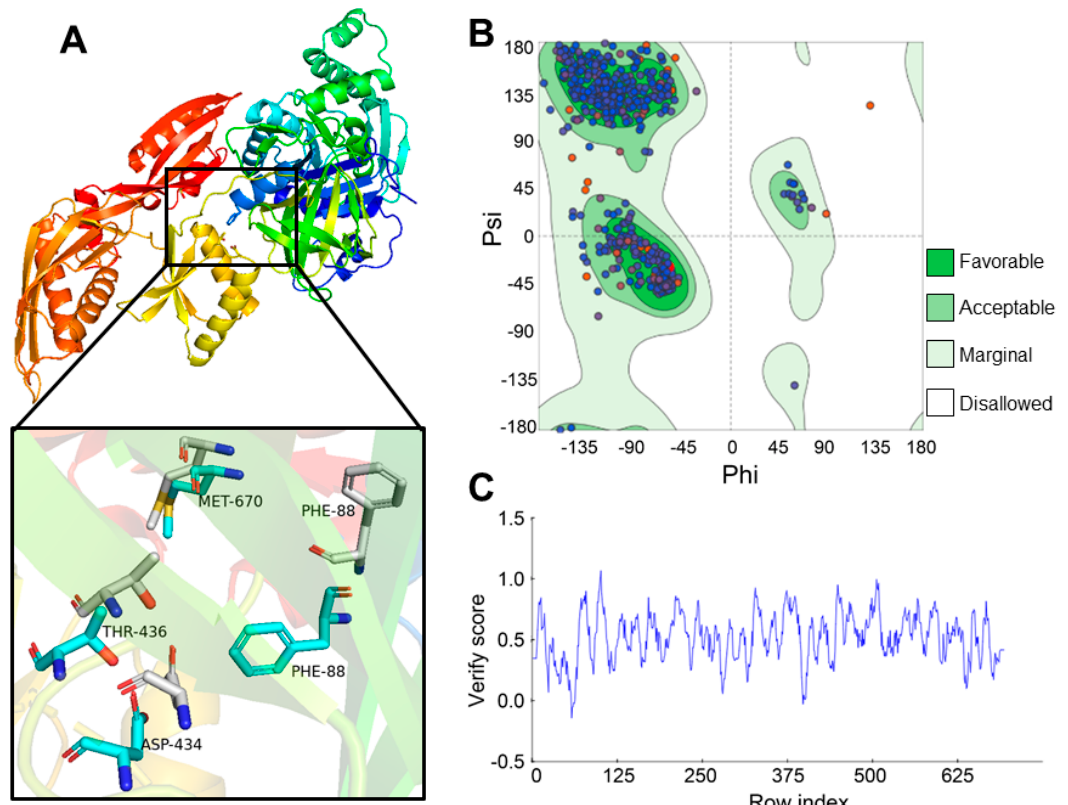
Figure 3. ( A ) 3D homology model of EF-G structure for docking; key residues related to the FA binding in the homology model are shown in the expended figure (cyan sticks) in comparison to the same residues in the reported apo structure (gray sticks). ( B ) Ramachandran plot of the 3D model. ( C ) Profile-3D analysis of the 3D model.